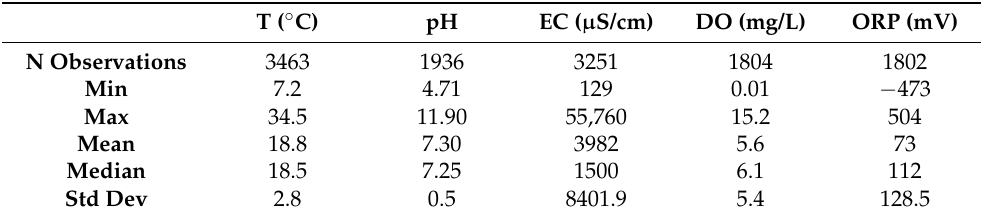
Table 3. Main statistical indicators of the physical-chemical parameters measured in the Apulia monitoring network.